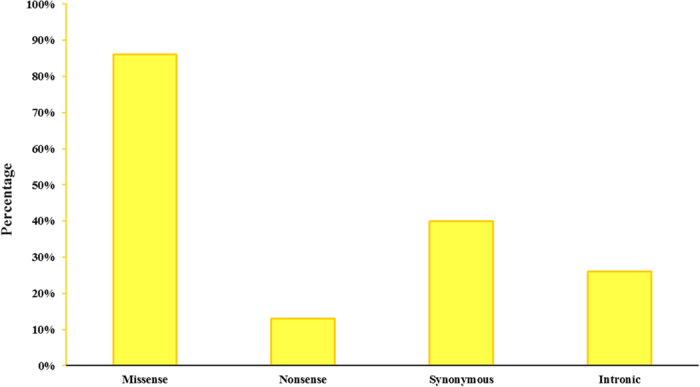
Graphical representation of pathogenic mutations type found in patients with more than one pathogenic mutation.Missense mutations are the most frequent in our patients, unlike nonsense mutations.